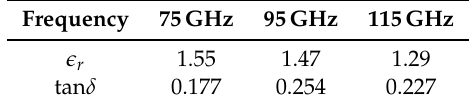
Table 1. WAVASORB VHP-8 electrical properties at